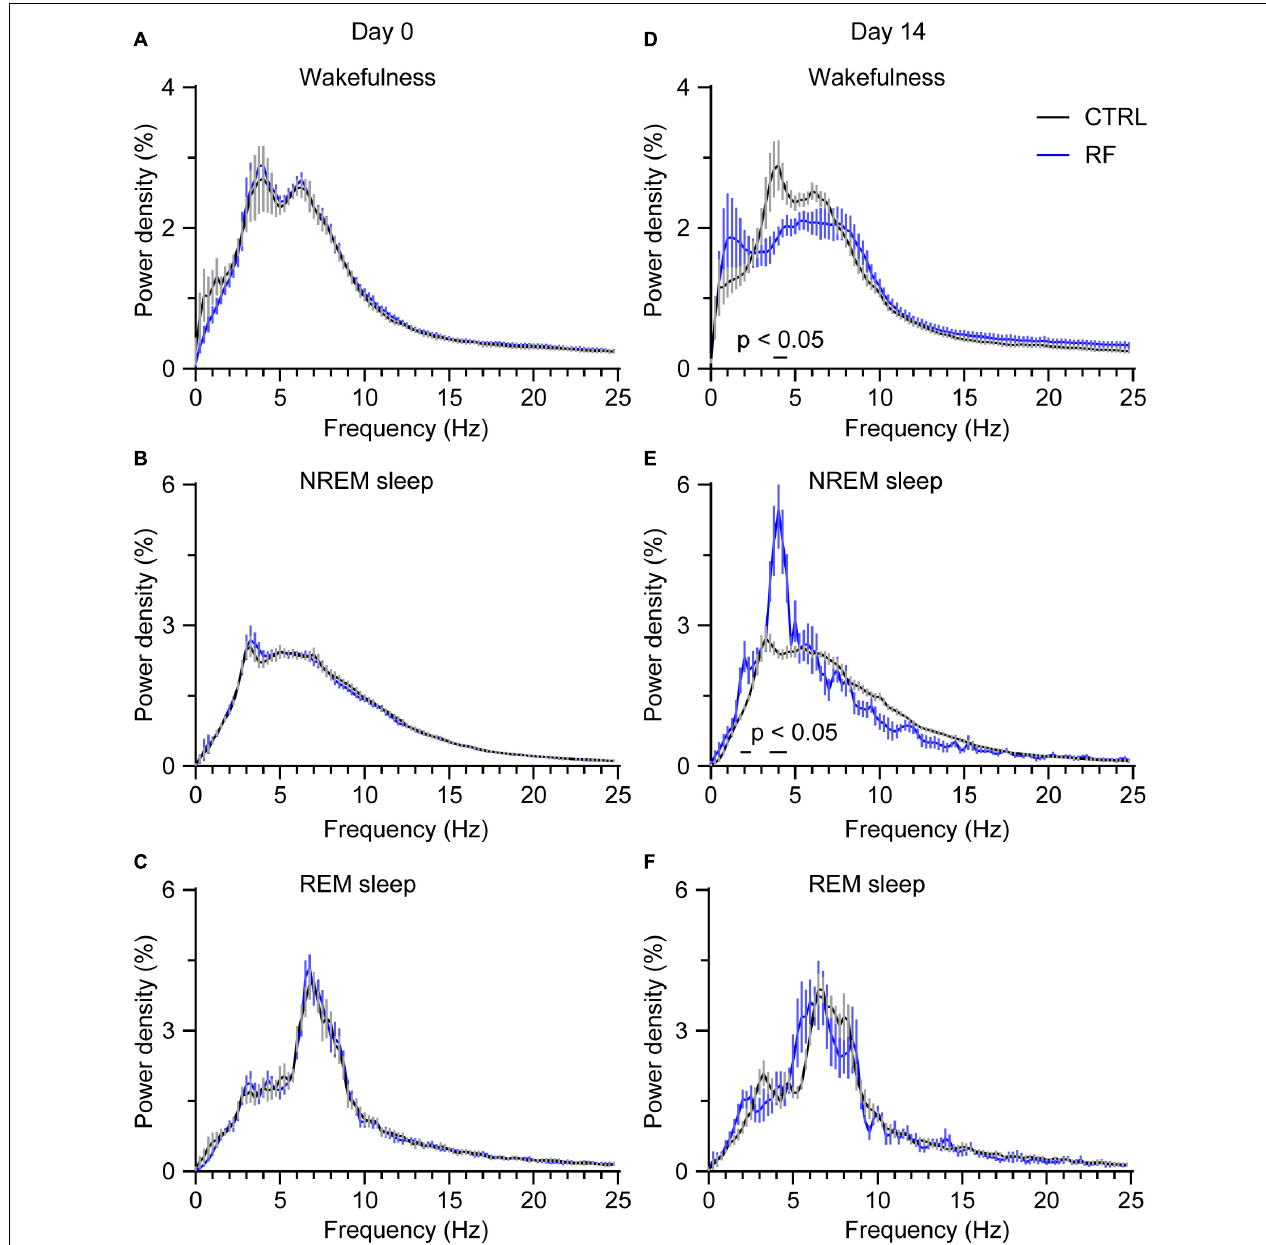
FIGURE 7 | Changes in the EEG power density during wakefulness, NREM sleep, and REM sleep in the 2 h proceeding the dark period (food availability). EEG power density during wakefulness (A) , NREM sleep (B) , and REM sleep (C) in the 2 h proceeding the dark period under the baseline condition (day 0 of the RF regime). EEG power density during wakefulness (D) , NREM sleep (E) , and REM sleep (F) in the 2 h proceeding the dark period (food availability) on day 14 of the RF regime. “The horizontal bars indicate where there is a statistical difference,” versus CTRL ( p <